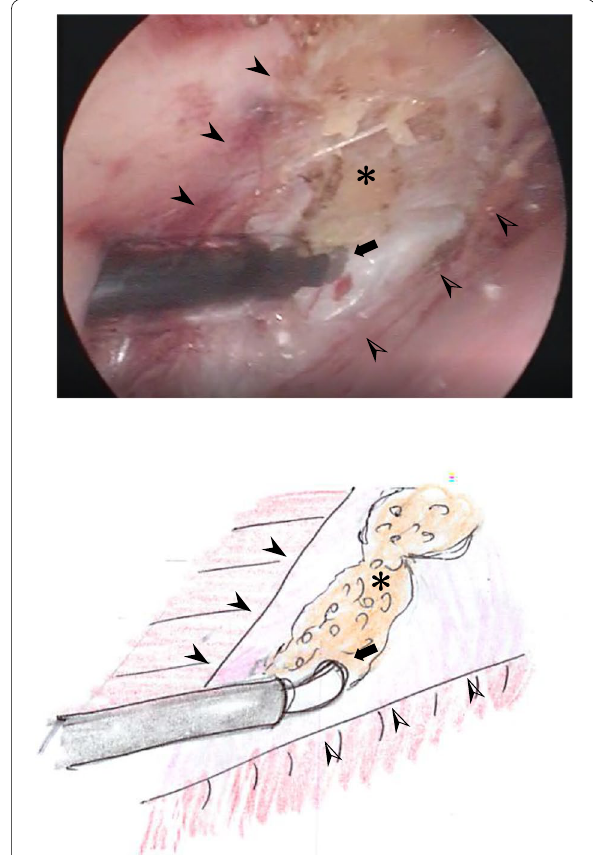
Fig. 3 Endoscopic view and a schema of the aponeurosis being transected by the electrocautery ( ➡ ). The subcutaneous fat ( ∗ ) is visible between the rim of the external oblique muscle ( ➤ ) and the rectus abdominis muscle ( ➣